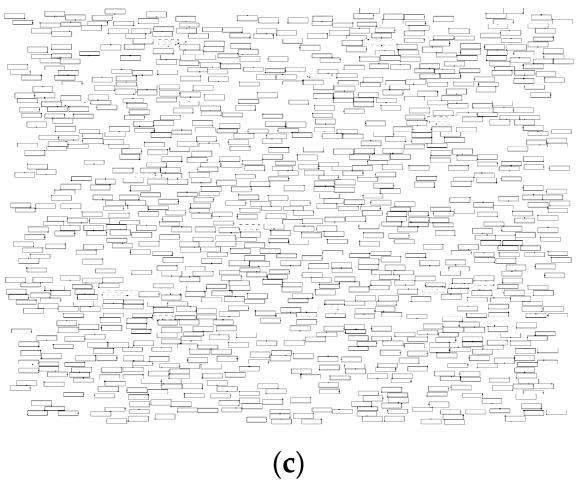
Figure 12. Labeling result for the VariableDensity instance with 1000 points. ( a ) Four-position model: 833 conflict-free labels; ( b ) four-slider model: 925 conflict-free labels; ( c ) the proposed model: 960 conflict-free labels.